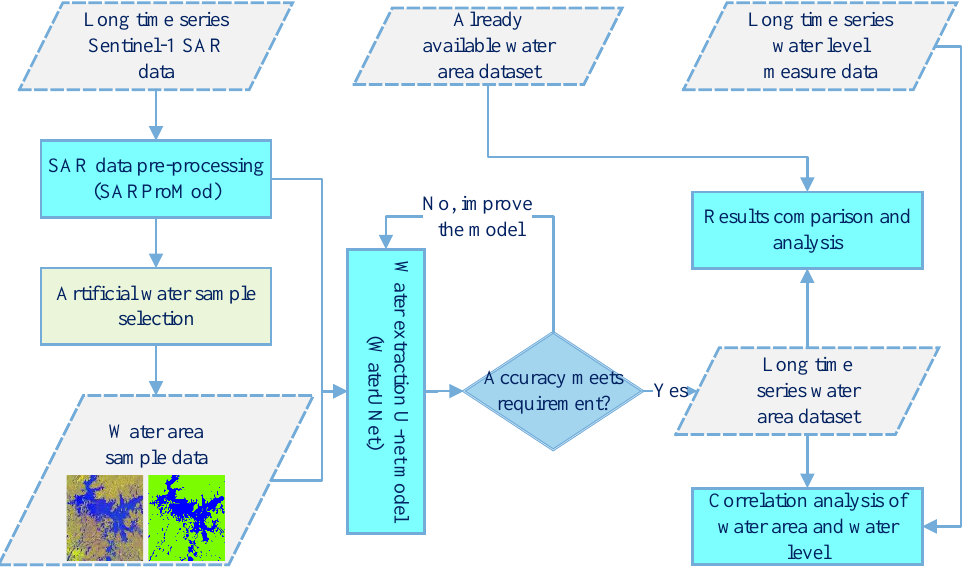
Figure 5. The flowchart showing the overall methods used in this study.